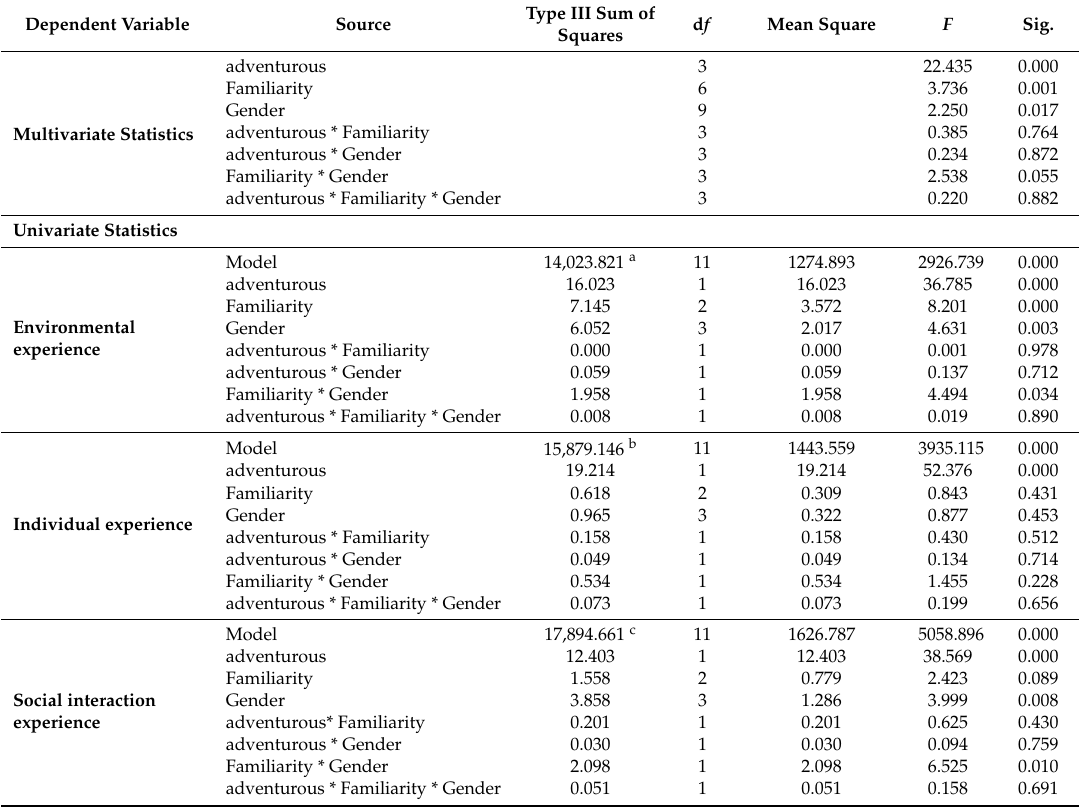
Table 6. MANOVA results for experience differences under the influence of personal traits and familiarity.